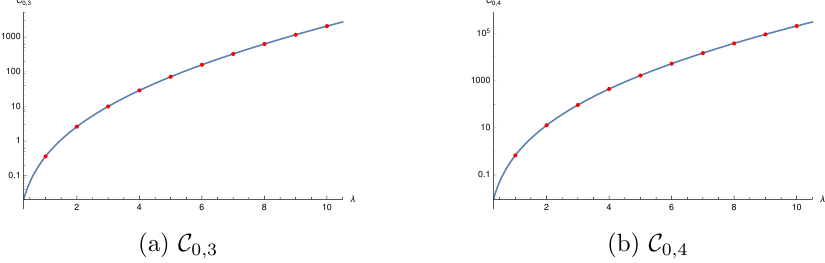
Figure 2. (a) and (b) are the plots of genus-zero three-point function C 0 ; 3 and four-point function C 0 ; 4 , respectively. The red dots are the exact values of the right hand side of (4.5) at N = 200, while the blue solid curves are the analytic result of C 0 ; 3 and C 0 ; 4 obtained from the topological